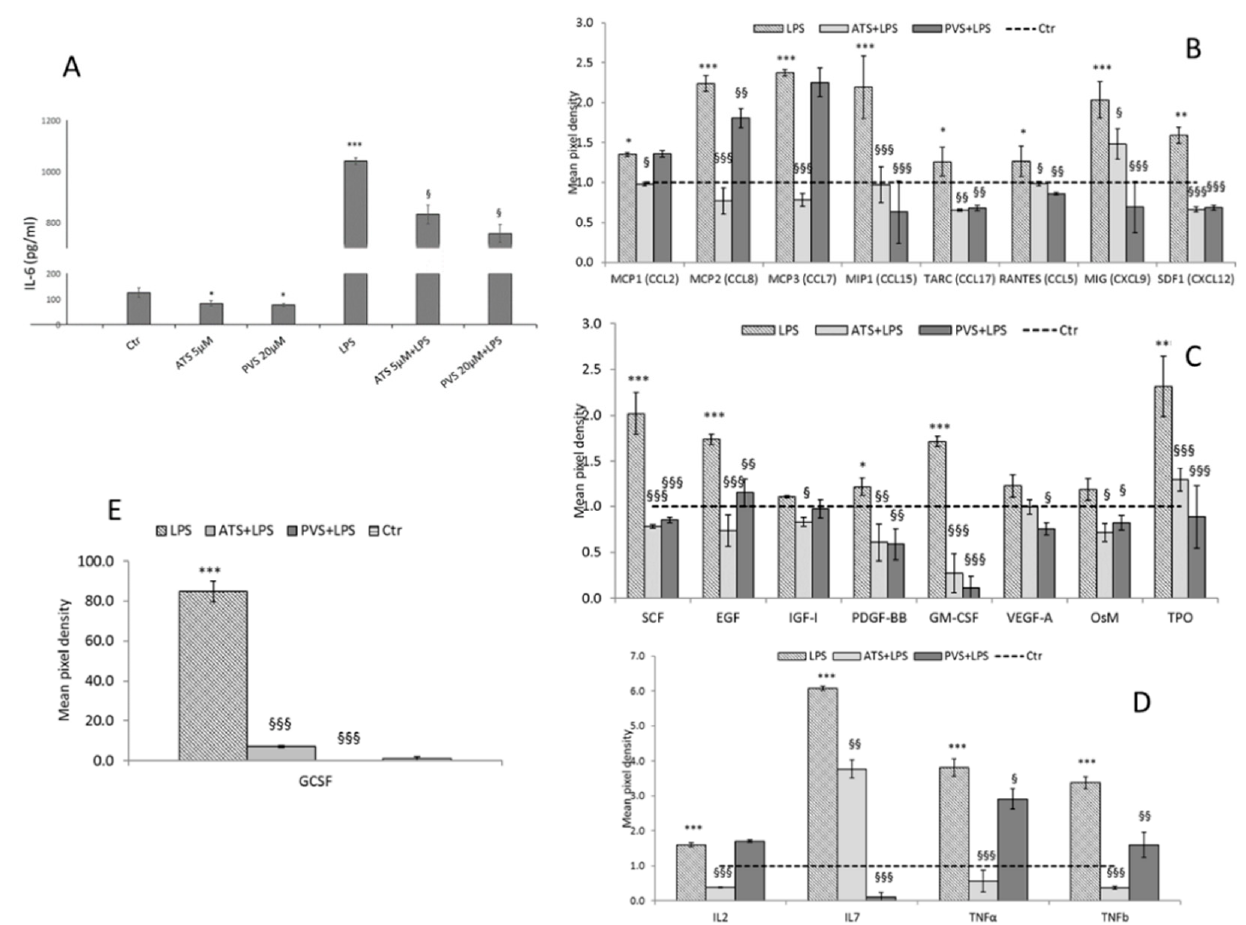
Figure 4. IL6 secretion in culture medium from A549-hACE2 cells treated with ATS and PVS alone or after stimulation with LPS, measured by ELISA ( A ). Effect of ATS and PVS on LPS-induced cytokines secretion in culture media from A549-hACE2 cells. Histograms represent densitometric analyses of the membrane spots on the antibody array ( B – E ). Data are expressed as mean ± SD of at least three independent experiments. * p < 0.05, ** p < 0.01, *** p < 0.005 vs. control. § p < 0.005, §§ p < 0.001, §§§ p < 0.005 vs. LPS.